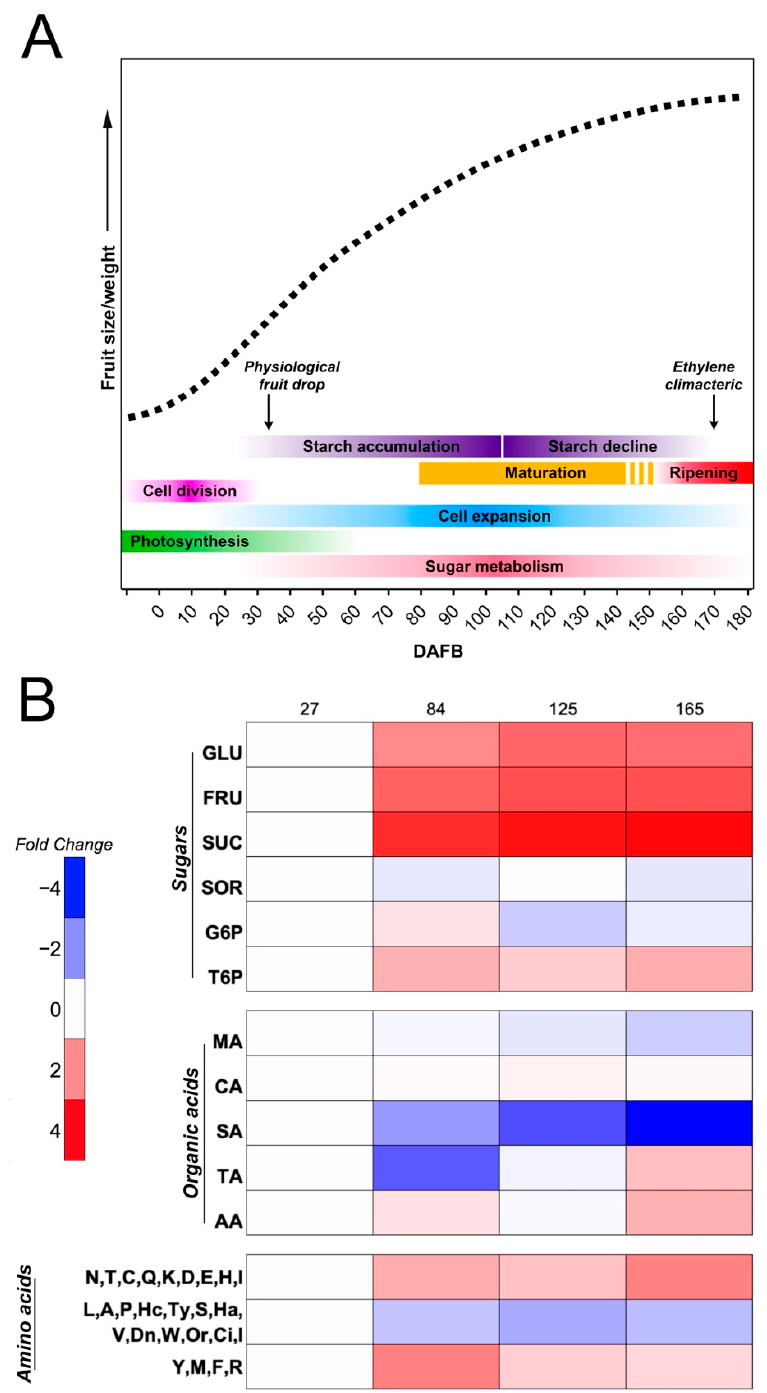
Figure 1. Apple growth curve (dashed line), highlighting main processes and primary metabolites. ( A ) Simple sigmoid growth pattern based on an expolinear equation for apple. The main physiological processes and events accompanying apple development are indicated. ( B ) Heatmap showing the time course progression of the levels of some of the most important sugars, organic acids, and amino acids found in apple at four developmental stages (27, 84, 125, and 165 DAFB). Levels were elaborated from references [24,25] and are reported as log 2 of the foldchange, keeping the first value equal to 1. GLU, glucose; FRU, fructose; SUC, sucrose; SOR, sorbitol; G6P, glucose-6-phosphate; T6P, trehalose-6-phosphate; MA, malic acid; CA, citric acid; SA, succinic acid; TA, tartaric acid; AA, ascorbic